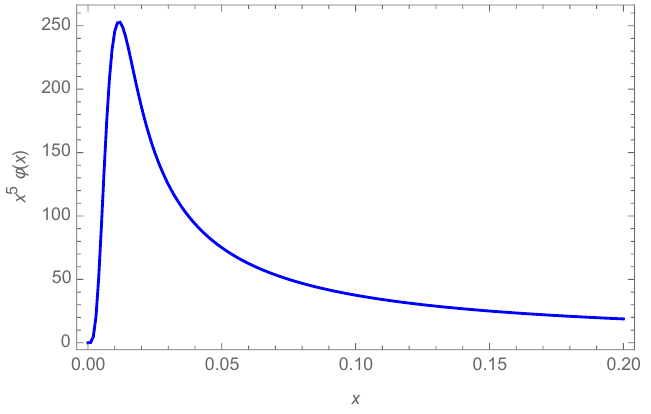
Figure 3. Small x behavior of the product x 5 ϕ ( x )